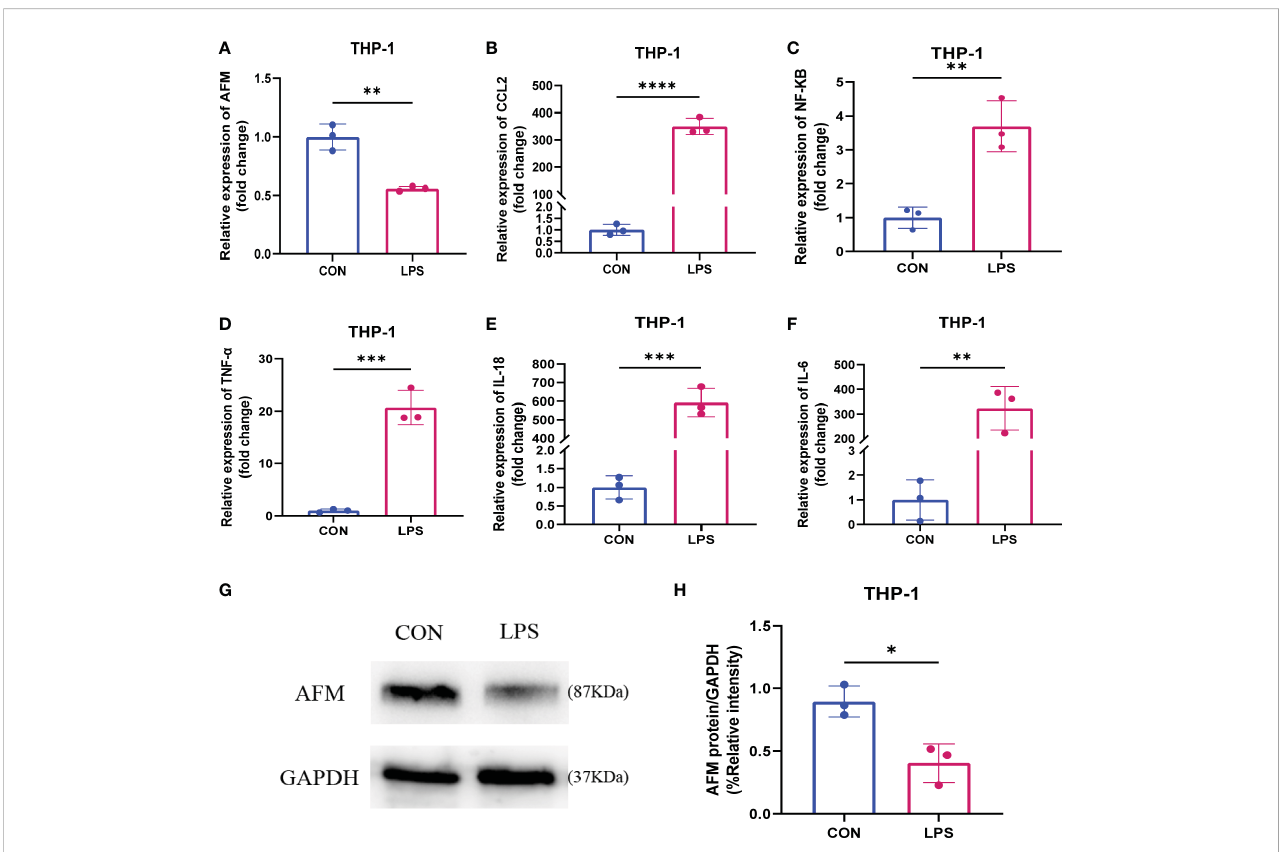
FIGURE 9 (A – F) Relative expression levels of AFM, CCL2 and in fl ammatory index mRNA in LPS-stimulated monocytes (THP-1). (G, H) The immunoblotting (G) and quanti fi cation grayscale value of AFM in THP-1 cell 24 h post-LPS stimulation (H) . *p < 0.05, **p < 0.01, ***p < 0.001, ****p <